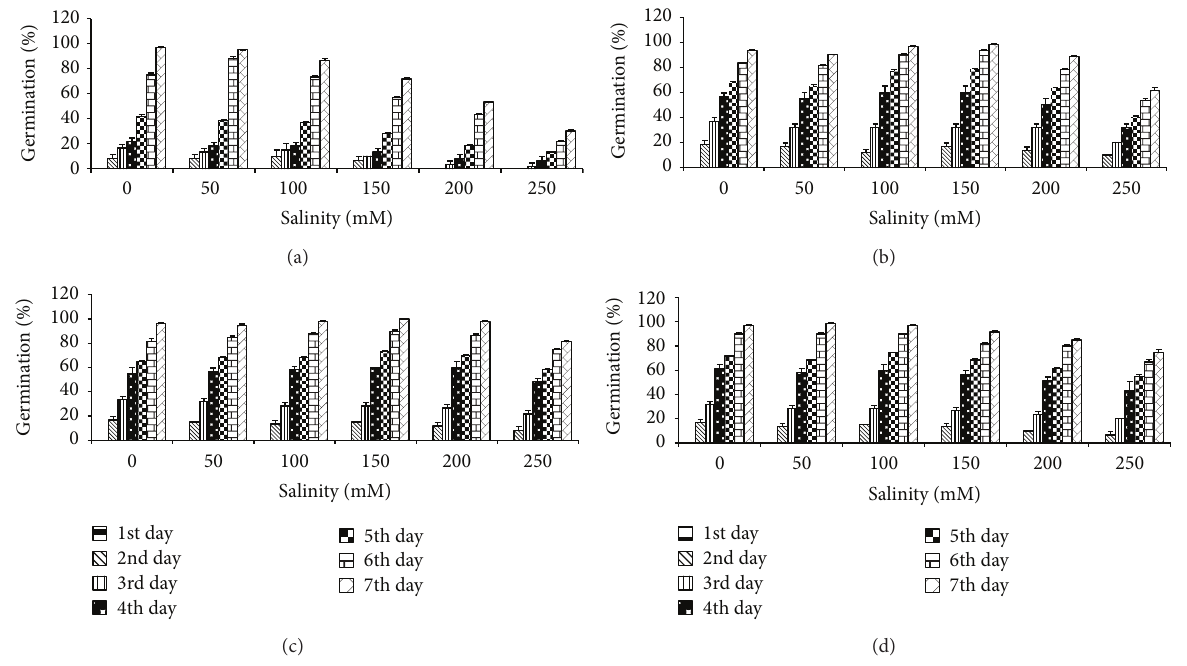
Figure 2: Effect of NaCl on germination percentage of T. aestivum grains presoaked in different concentrations of Ulva lactuca : (a) control, (b) algal extract 1%, (c) algal extract 5%, and (d) algal extract 10%. Data are the mean of three replicates and error bars represent the standard errors of the